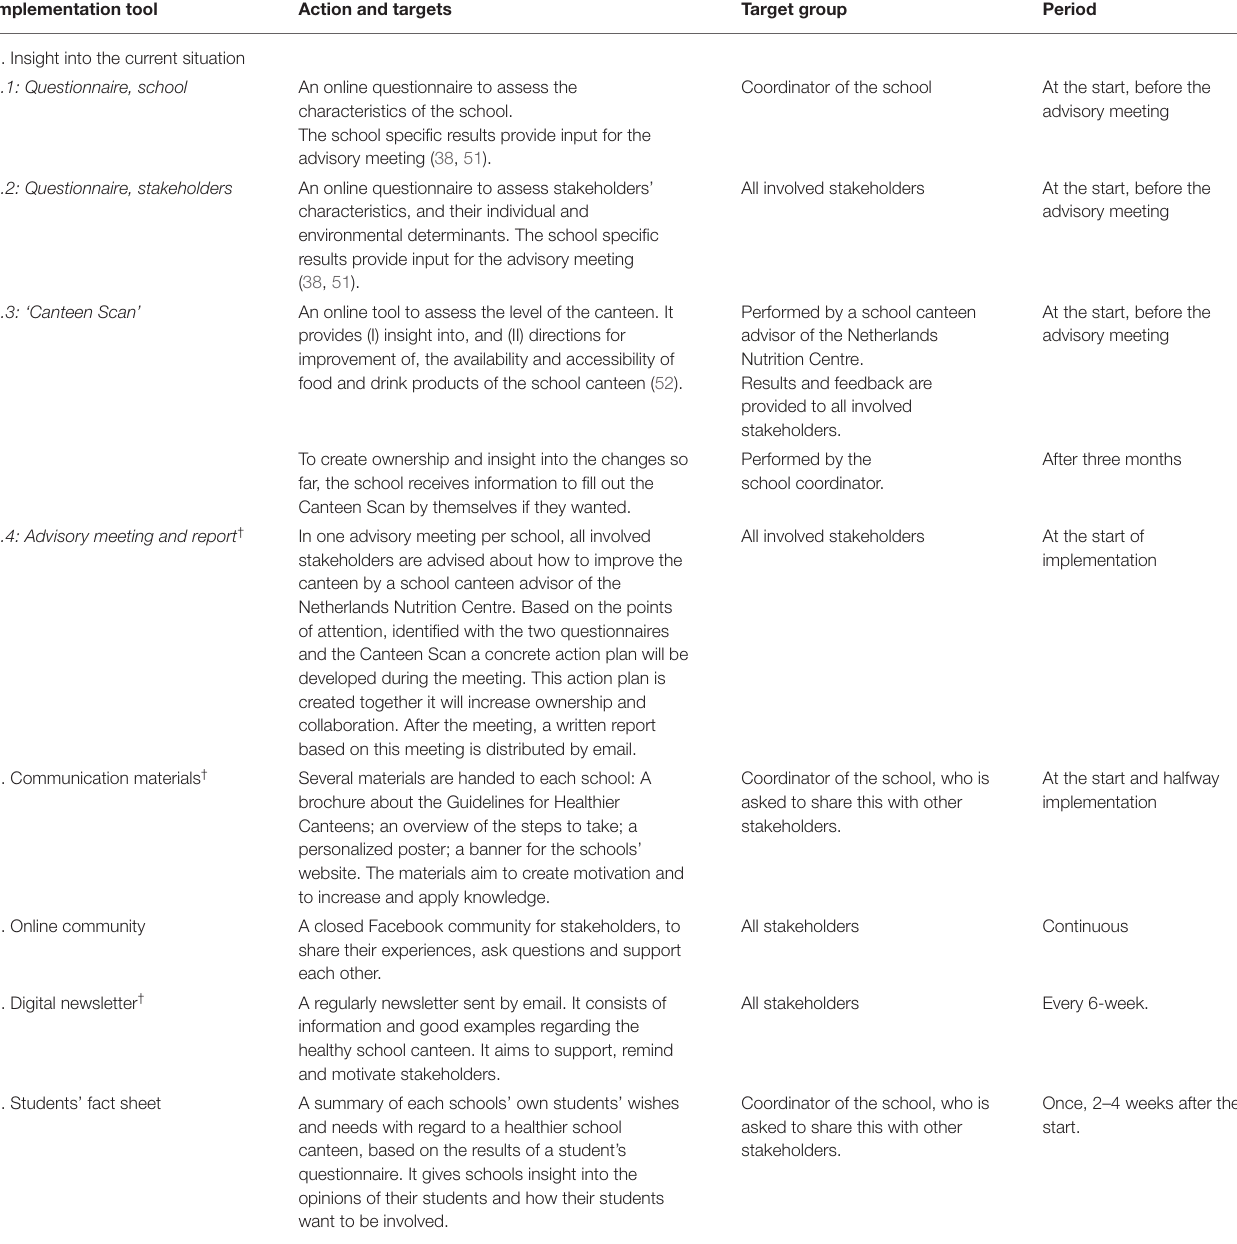
TABLE 2 | Description of the implementation plan to implement the Guidelines for Healthier Canteens * . Implementation